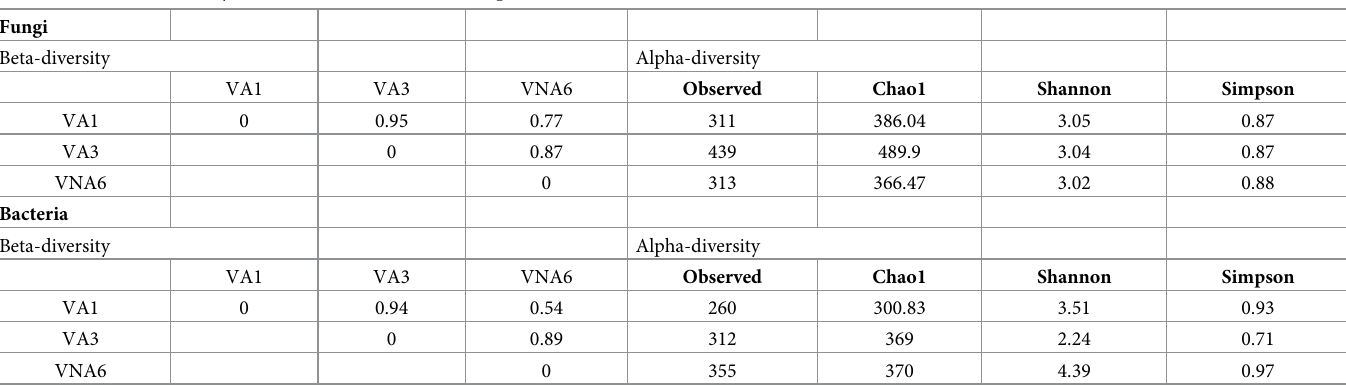
Table 4. Microbial diversity index for VA1, VA3 and VNA6 positions.